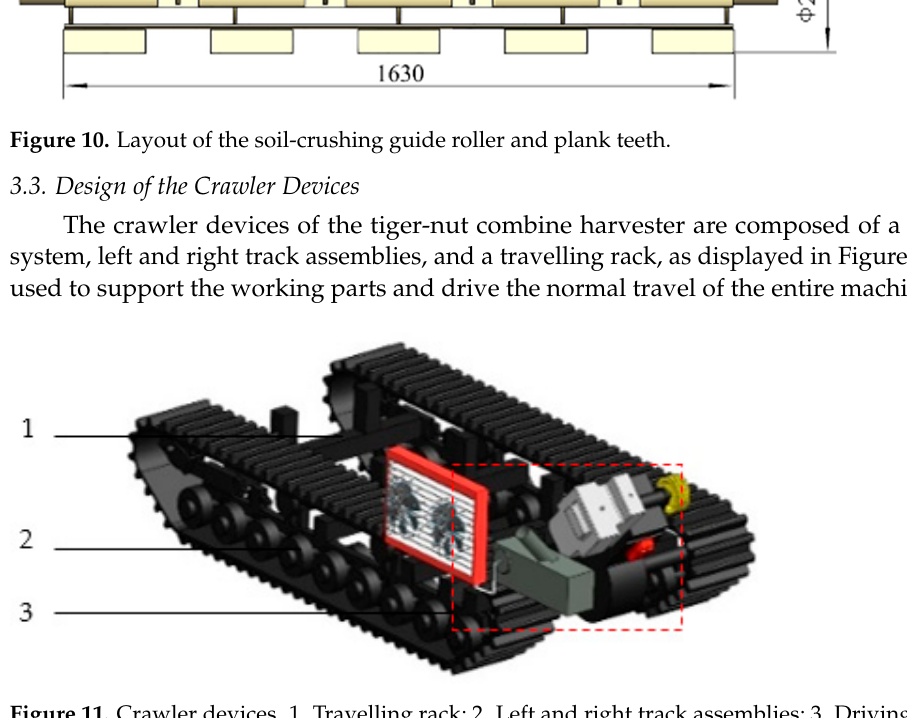
Figure 11. Crawler devices. 1. Travelling rack; 2. Left and right track assemblies; 3. Driving sys- tem.